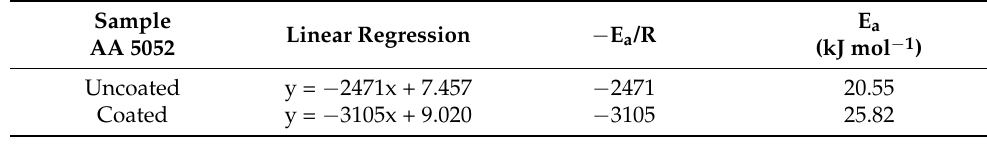
Table 3. Values of activation energy (E a ) for AA5052 alloys with and without chithosan for 20 min EPD time.